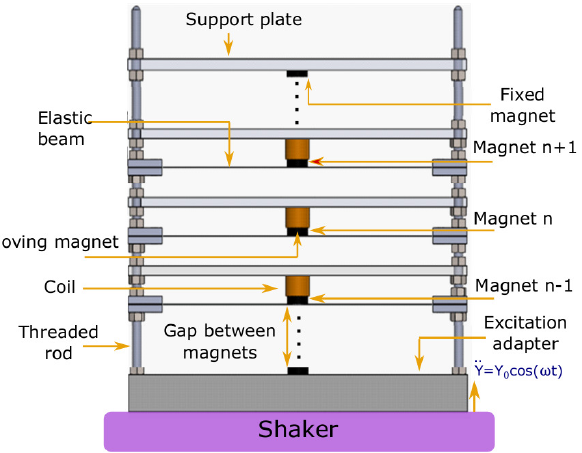
Figure 1. Device of the electromagnetic vibration energy harvester of N coupled